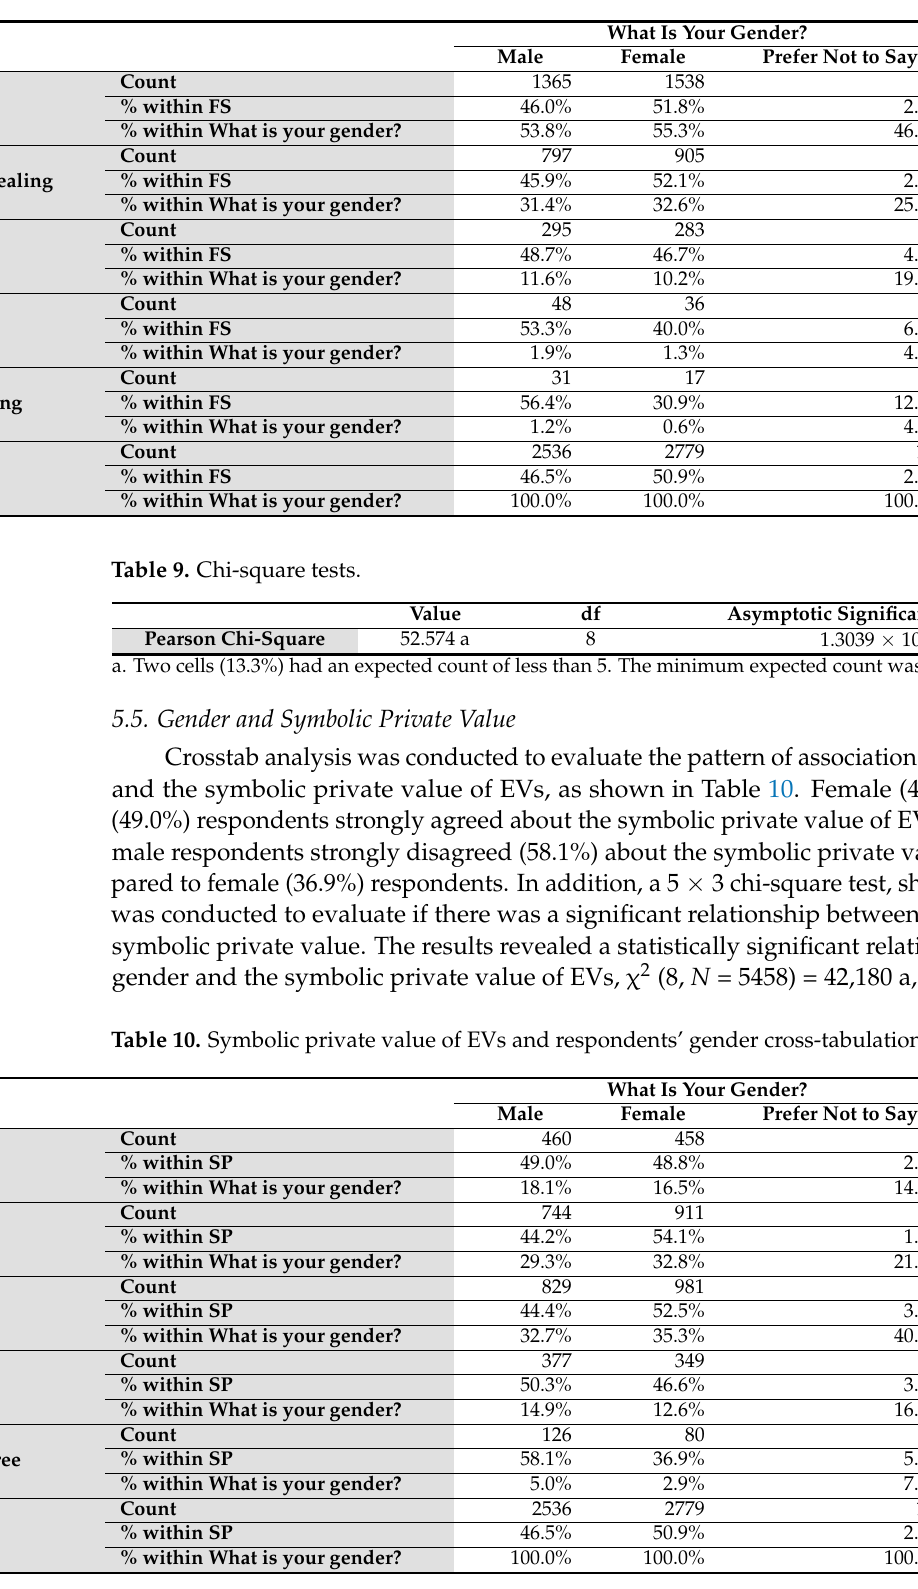
Table 8. Functional societal value of EVs and respondents’ gender cross-tabulation.